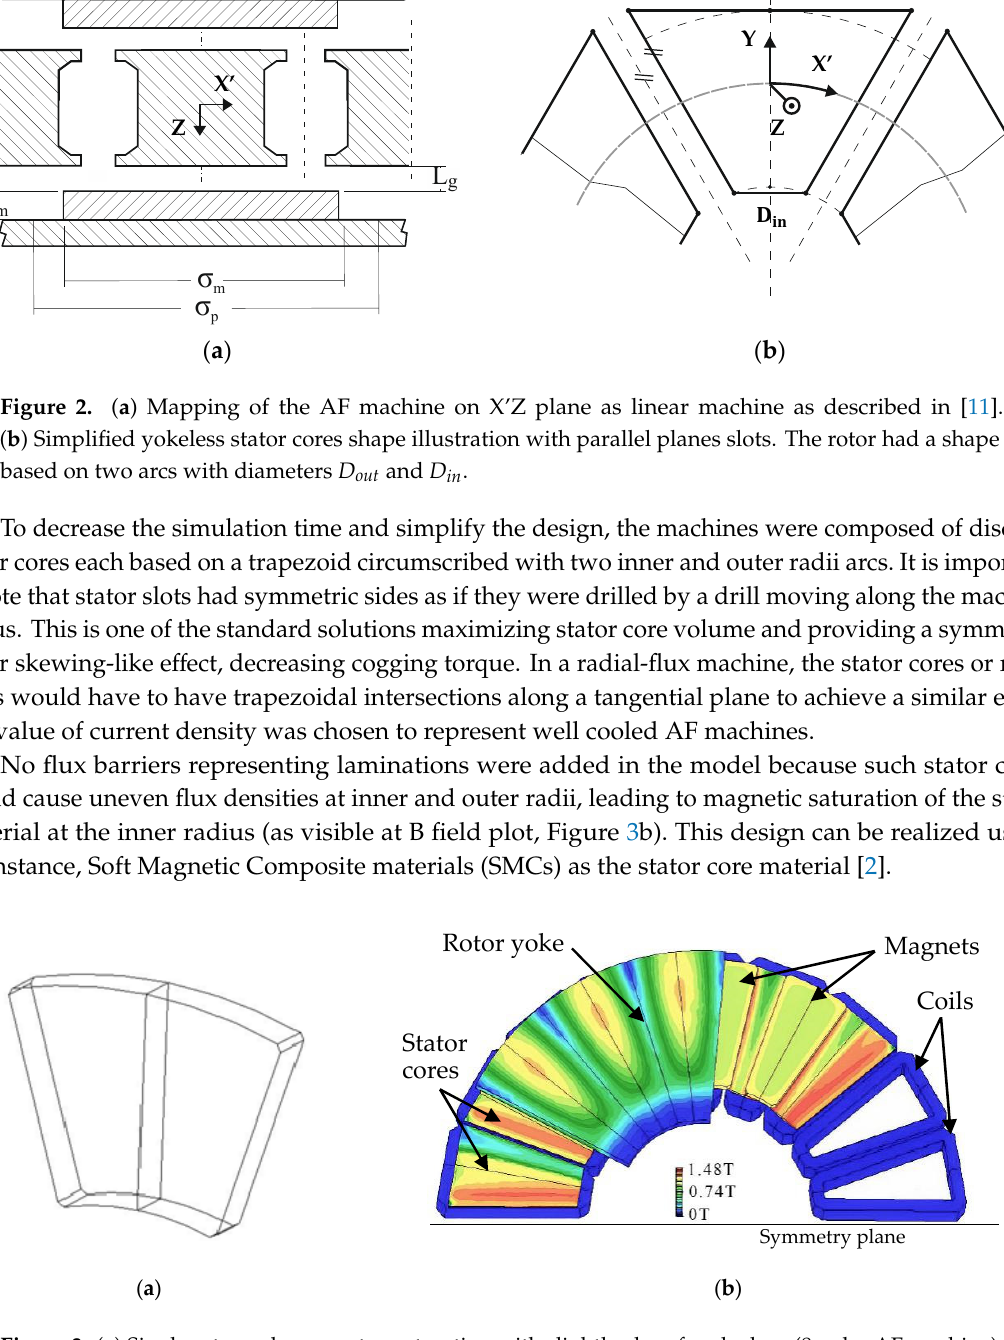
Figure 3. ( a ) Single rotor pole magnet construction with slightly chamfered edges (8 poles AF machine). ( b ) Symmetric part of the modeled machine with some of the rotor yokes, magnets and stator cores hidden (16 poles AF machine)—magnetic flux density in tesla [T] plotted in color.